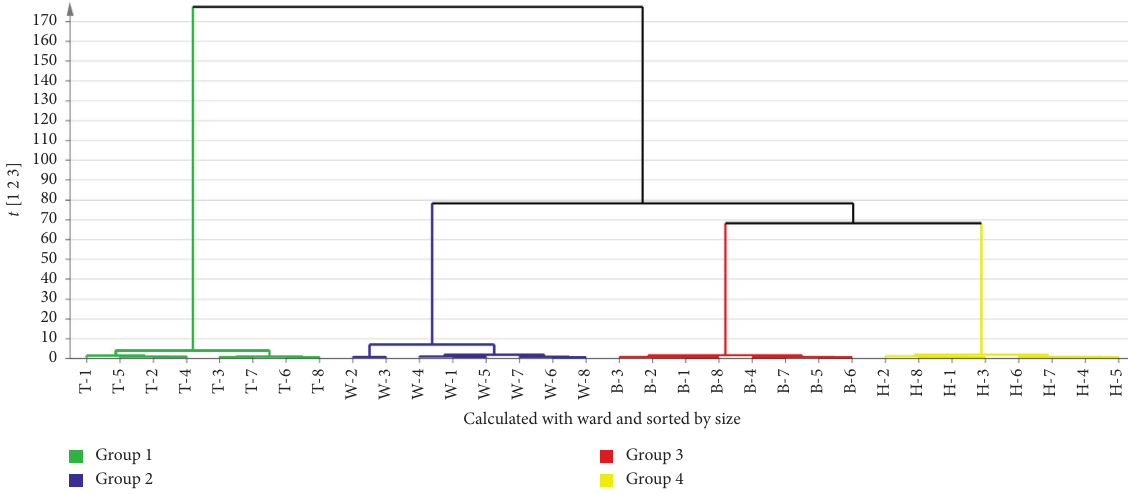
Figure 2: The result of dendrogram by HCA (group 1, T-1 ∼ T-8; group 2, W-1 ∼ W-8; group 3, H-1 ∼ H-8; group 4, B-1 ∼